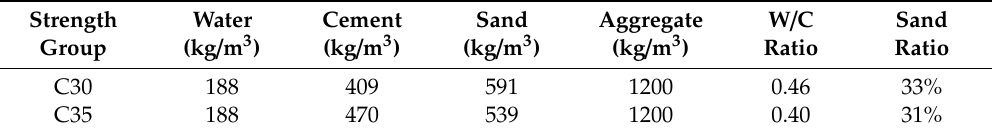
Table 8. Mix composition of concrete.